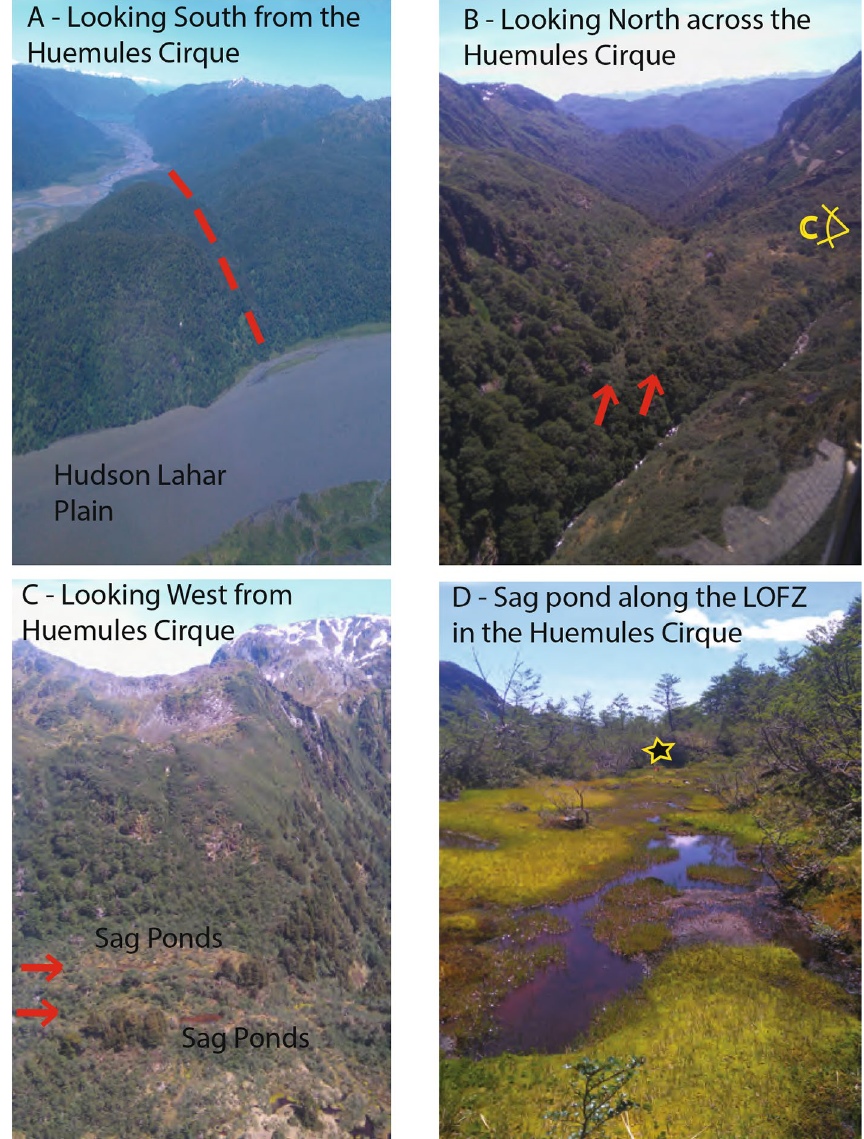
Figure 6. Field photos from January 2016 from along the master fault within the LOFZ in and around the Huemules Cirque (HC). ( A ) Oblique helicopter photo looking south toward Exploradores Bay and Laguna San Rafael from the HC. Main fault trace is the low forested valley. Note the young lahar plain from the Hudson Volcano. ( B ) Oblique helicopter photo looking north along the LOFZ over the HC. Red arrows show two lineaments consistent with displacements observed (shown in Fig. 5), and sag ponds. Note the widening of the main HC valley to the North versus the narrow valley with the Huemules Creek draining south. Orientation of photo C shown in panel. ( C ) Oblique Helicopter photo looking West (position shown in ( B )), showing the two main lineaments along the master LOFZ and sag ponds. Note how the valley widens on the right of the photo as per the width of the main glacial valley that is being translated northwards by long term dextral slip along the LOFZ (i.e. the HC is being beheaded over time due to northwards dextral motion along the LOFZ). ( D ) Field photograph looking North along the LOFZ at the sag pond shown in ( C ). This low-lying (along strike) linear pond is consistent with the main damage zone of the master fault here. Star is located above a machete with flagging tape attached stuck in the ground for scale (~ 40 cm is above ground in photo). Field and Helicopter Photographs by G.P. De